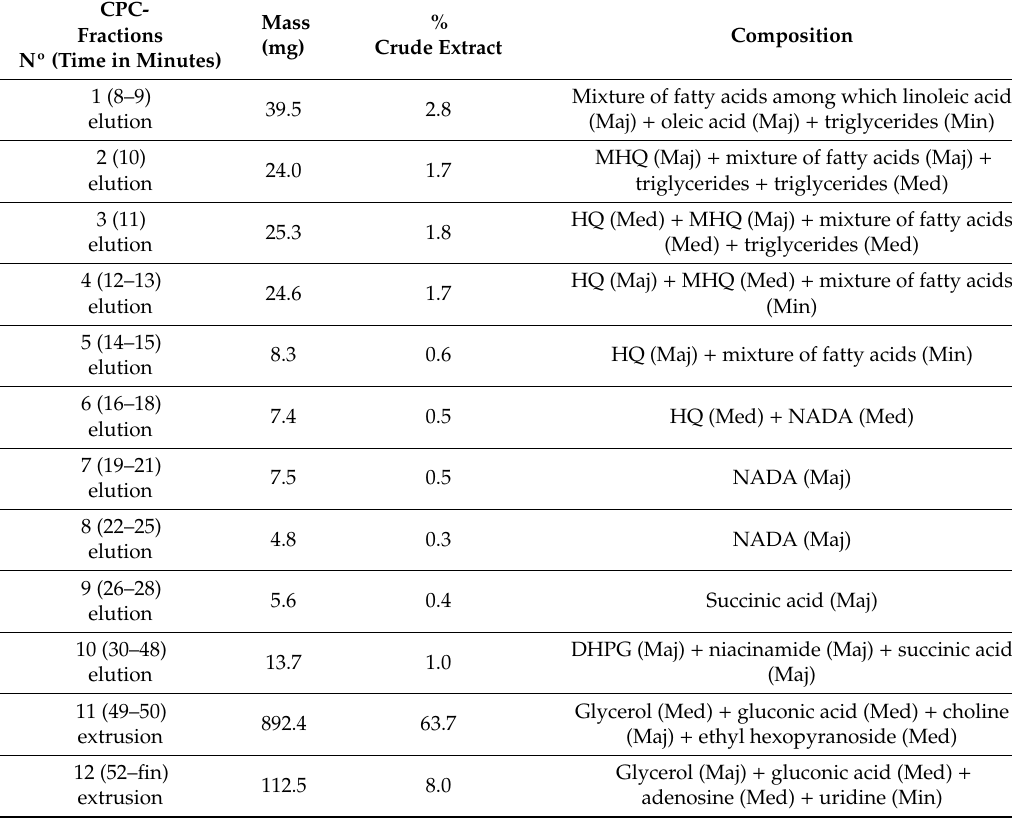
Mass and global composition of the fractions produced by centrifugal partition chromatography (CPC) of an ethanolic M. bellicosus extract (soldier caste) collected from Abomey-Calavi. HQ—Hydroquinone, MHQ—Methylhydroquinone, NADA— N